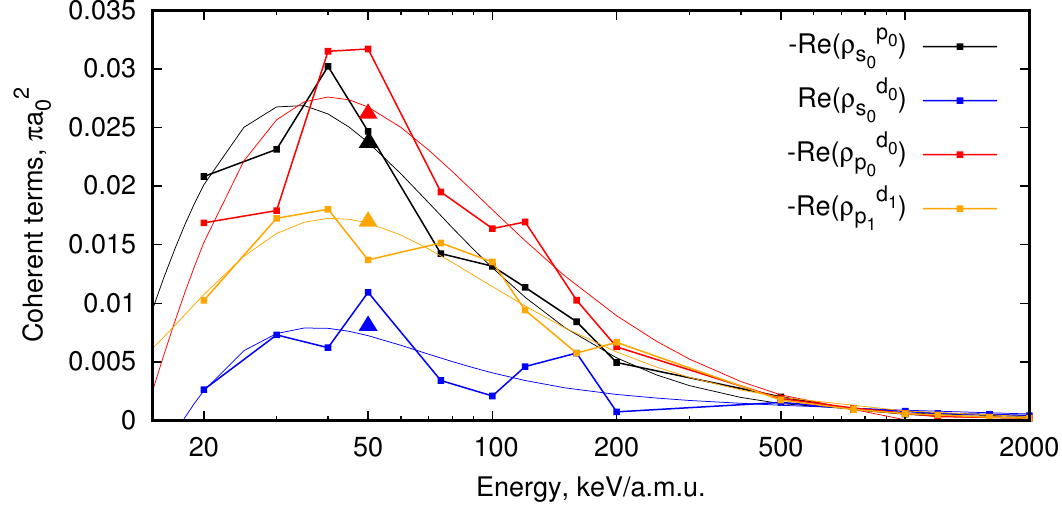
Figure 3. Real parts of the excitation coherence terms to n = 3 (thick lines with squares). The results of the fit are shown as thin lines with the same colours. The new CCC data at 50 keV are shown as triangles using the same colours (Table 1 of Reference